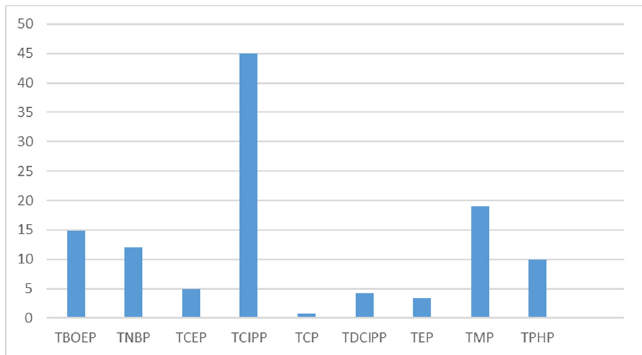
Figure 5. Maximal median OPFR concentrations found in breastmilk in Europe, 2000–2019 (ng/g of lipid weight) [49,56].